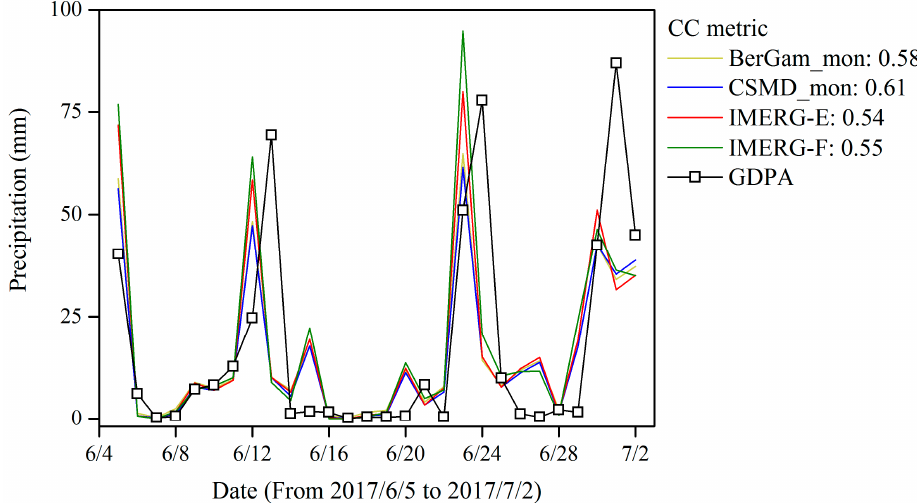
Figure 11. Performance of two bias-correction approaches on satellite precipitation IMERG-E in a summer heavy rainfall event during 5 June 2017–2 July 2017. Values of Correlation Coefficient ( CC ) metric between the raw IMERG-E, bias-corrected IMERG-E, and IMERG-F against GDPA were displayed in the legend. To ensure the lines are clearly observed, only the monthly time window scheme in each bias correction approach (with best performance among three time-window schemes in each approach), i.e., BerGam_mon and CSMD_mon, was used to exhibit here.